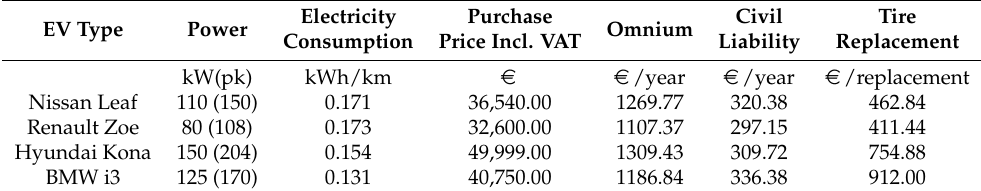
Table 7. EV specific characteristics and costs [41–44,47,48].